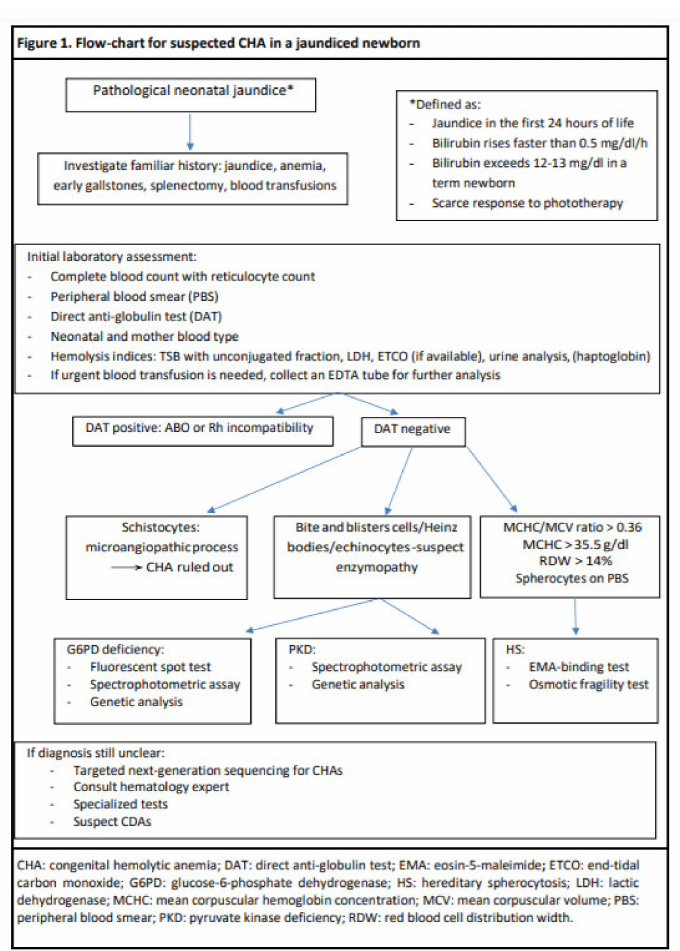
Figure 1. Flow-chart for suspected CHA in a jaundiced